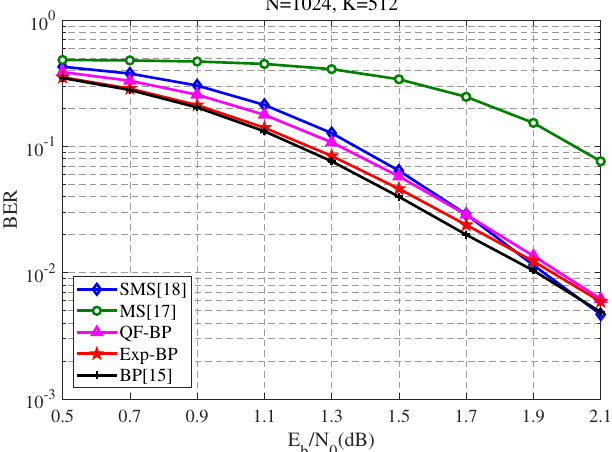
Figure 3. The BER performance of different algorithms with N = 1024.